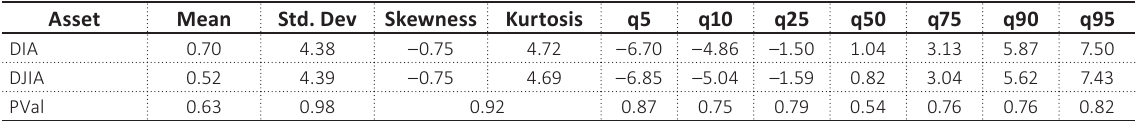
Table 4. Statistical comparison of DJIA and